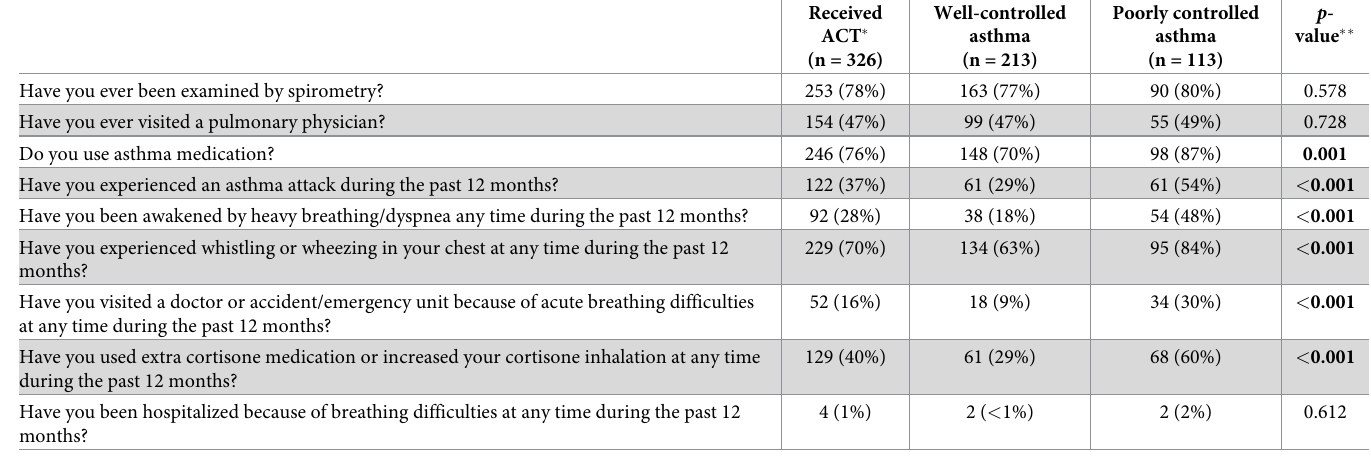
Table 3. Prevalence of spirometry, pulmonary physician examination, and medication use among those with physician-diagnosed asthma and symptoms during the previous 12 months.